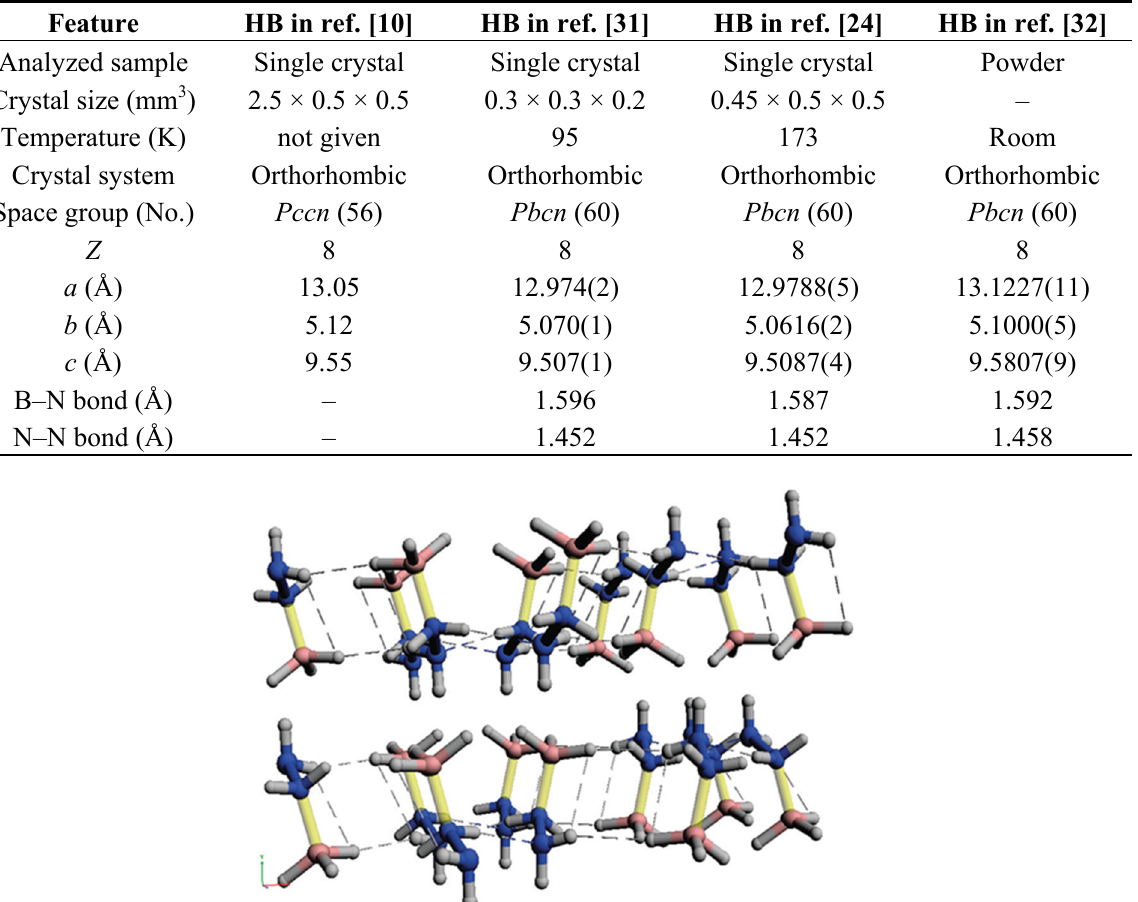
Table 1. Crystallographic data of hydrazine borane (HB) from various works (with ref. as reference and No. as number).